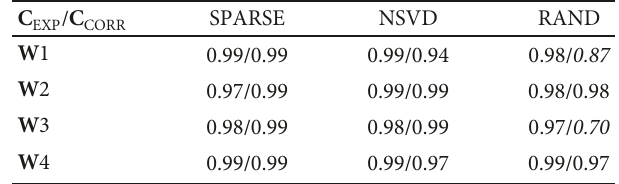
Table 2: Cosine similarity QR between pairs of homologous synergy vectors extracted via di ff erent initialization methods. Similarity values are presented when the extraction is performed